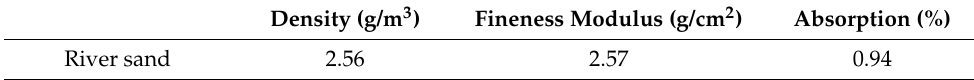
Table 4. Physical analysis of sand.